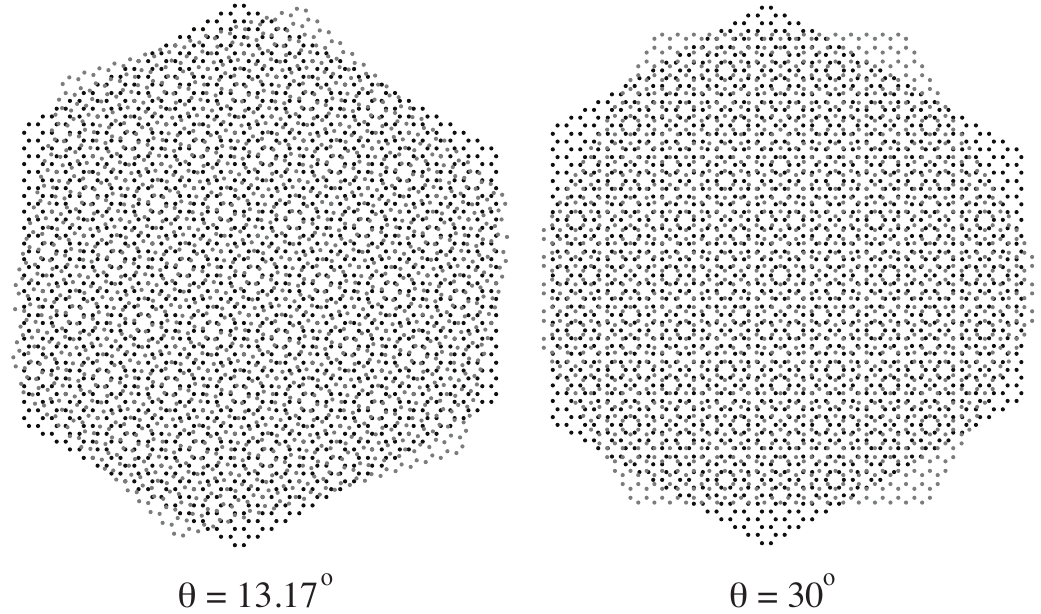
Figure 1. Two graphene layers rotated by θ = 13.17 ◦ and θ = 30 ◦ . O-points are seen as